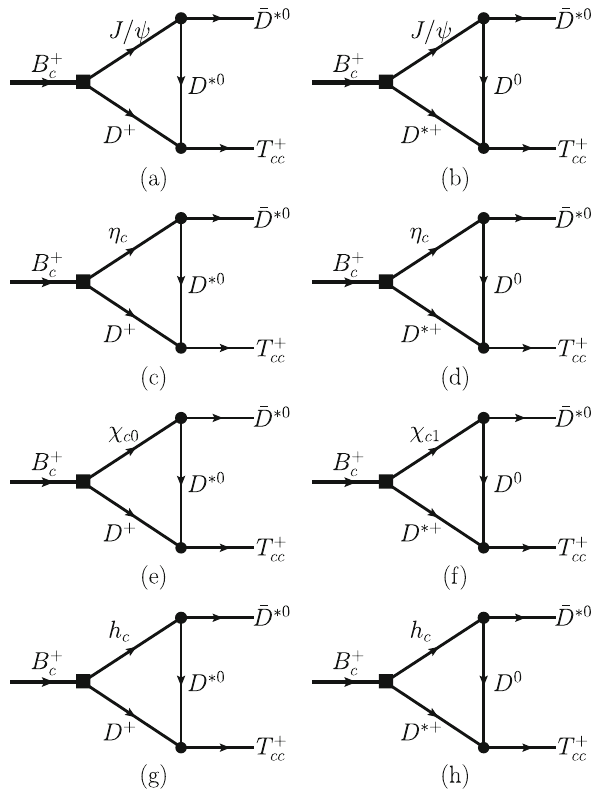
Fig. 2 Rescattering diagrams contributing to B + c → T + cc ¯ D ∗ 0 . The boxes and dots represent the weak and strong vertices,